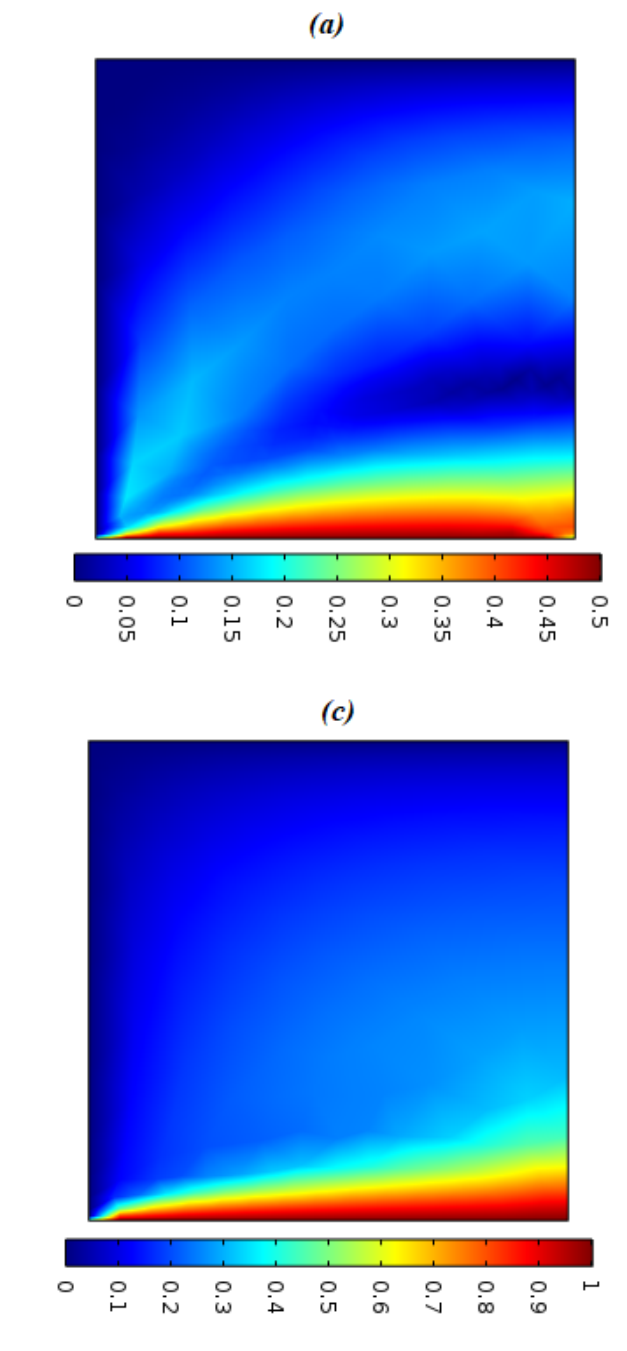
Figure 10. ( a ) Surface plot for velocity, ( b ) streamlines, ( c ) surface plot for temperature, ( d ) isothermal Figure 10. (𝐚) Surface plot for velocity, (𝐛) streamlines, (𝐜) surface plot for temperature, (𝐝) iso- contours using software with U w = 0.5, k ( T ) = 45 ( 1 + 30 T ) , β = 0.7, E 1 = 100, M = 0.5, E c = thermal contours using software with 𝑈 (cid:3050) = 0.5, 𝑘(𝑇) = 45(1 + 30𝑇), 𝛽 = 0.7, 𝐸 (cid:2869) = 100, 𝑀 = 0.5, 𝐸 = 0.7 . (cid:3030)